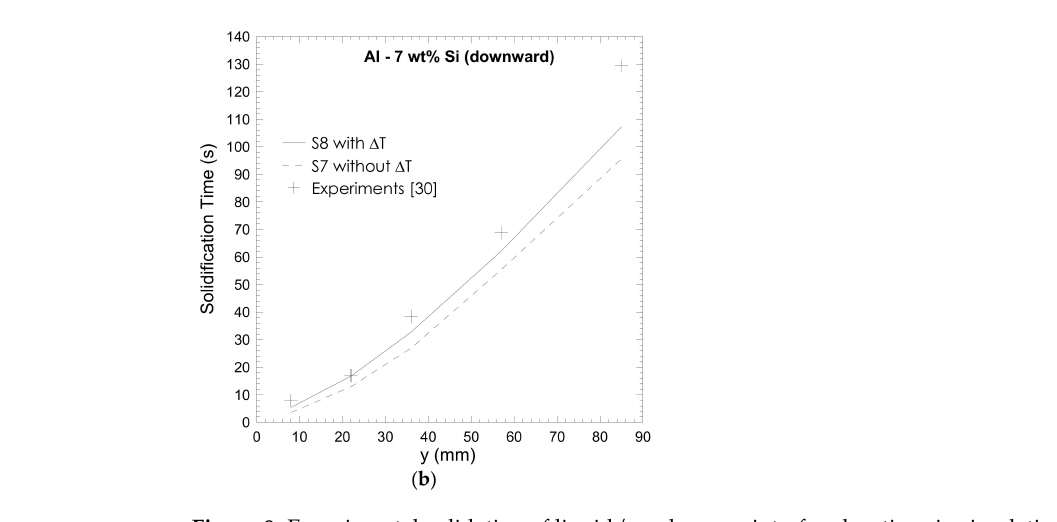
Figure 9. Experimental validation of liquid/mushy zone interface locations in simulations S6 and S8 (downward solidification); also shown is the importance of incorporating undercooling, ∆ T for valid simulations; ( a ) simulations S6 and S5, and ( b ) simulations S8 and S7.